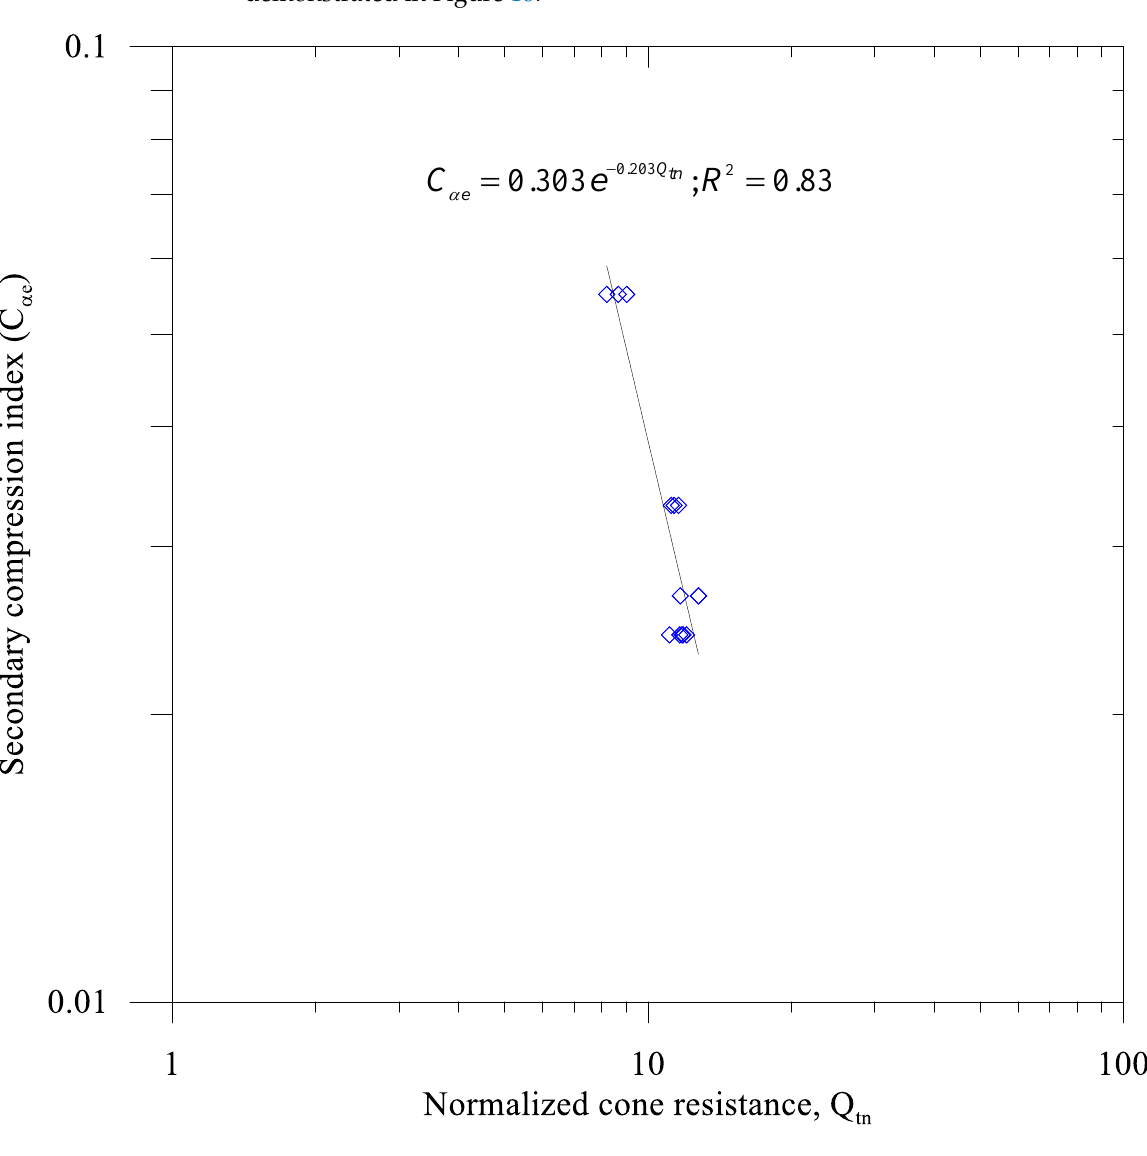
Figure 16. Relationship of the measured secondary compression index and stress state.